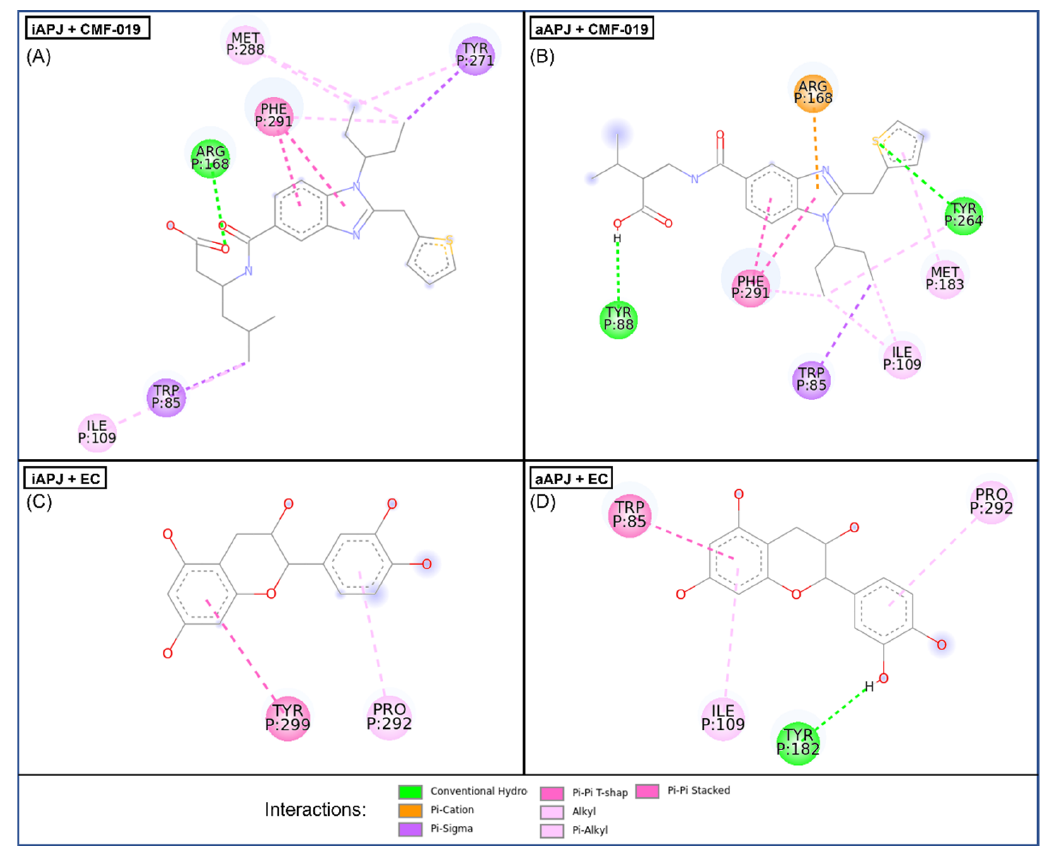
Figure 4. In the four images, we present the binding site and the interactions of the molecular docking results. ( A ) CMF ‐ 019 binds to the iAPLNR receptor and shows eight hydrophobic interactions and one polar interaction, of which it is worth highlighting two π‐π interactions with the Phe291 residue and the hydrogen bond with the Arg168 residue. ( B ) The CMF ‐ 019 binds to the aAPLNR receptor and establishes eight hydrophobic interactions, two electrostatic interactions, and one ionic, of which we can highlight two π‐π with the Phe291 residue; two hydrogen bonds, one with Tyr88 and one with Tyr264; and finally, the formation of a π‐ cation with residue Arg168. ( C ) EC in the inactive conformation of the receptor (iAPLNR) establishes few interactions in contrast to the other three assays, counting only two interactions of a hydrophobic nature with residues Pro292 and Tyr299. ( D ) On the other hand, the EC in the active conformation of the receptor (aAPLNR) establishes four interactions, three hydrophobic and one electrostatic, of which it is worth highlight ‐ ing the hydrogen bond with Tyr182 and the π‐π with Trp85.APJ = APLNR. Images were made with Discovery Studio [39].